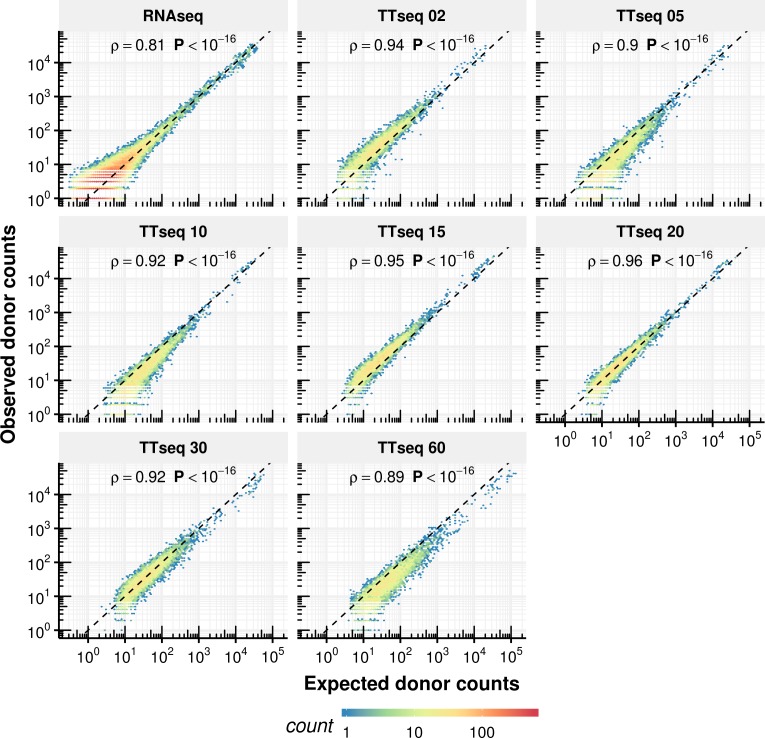
Comparison of expected counts of the constant rate model with observed experimental counts.Expected donor counts based on the constant rate model vs. the experimentally observed counts.